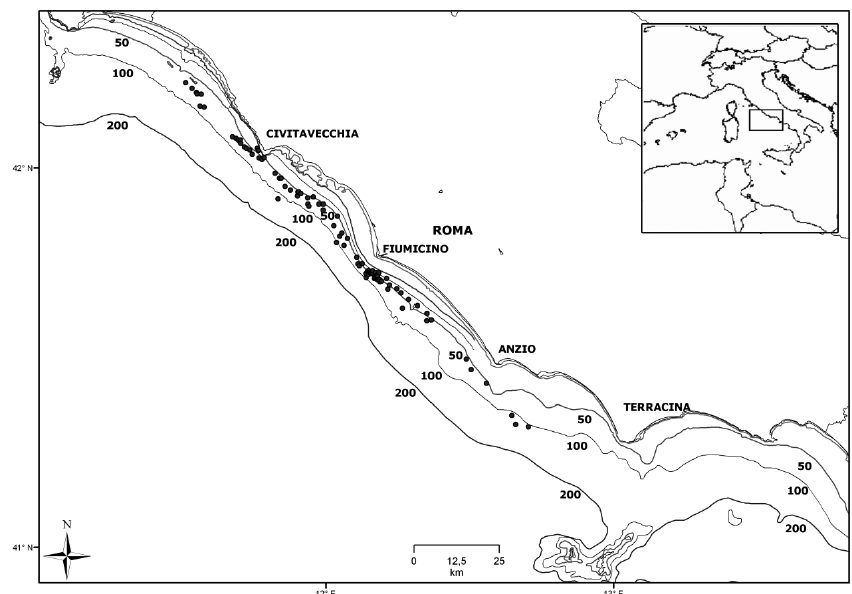
Fig . 1. – Study area. Points represent the trawl stations located on the continental shelf of the central western coasts of